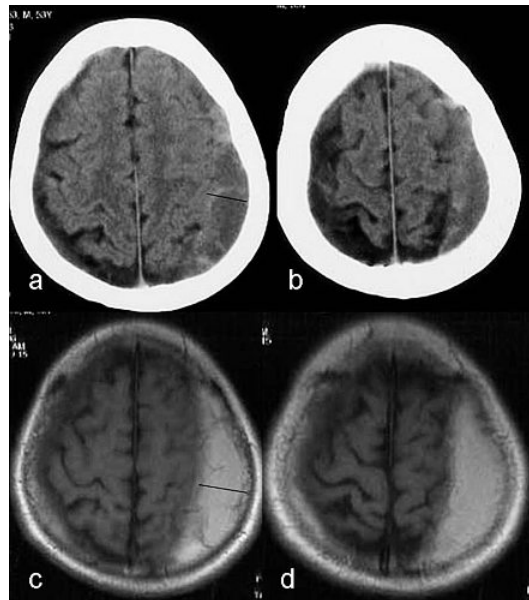
Difference of haematoma thick- ness on CT and MR imaging.